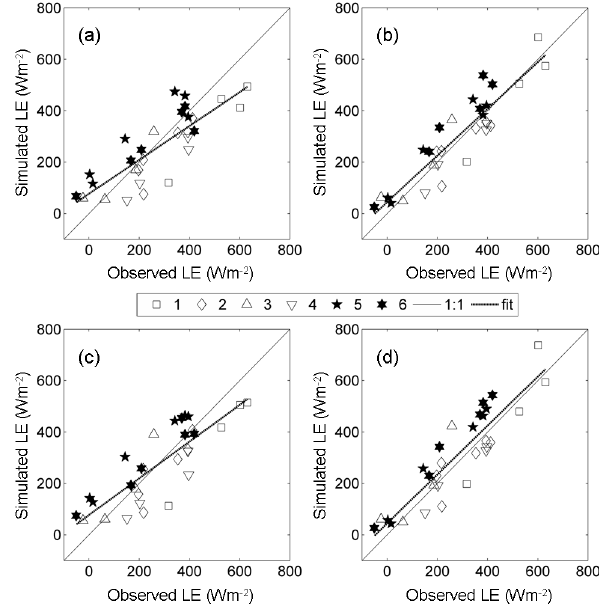
Fig. 8. Same for Fig. 7 but using modeled available